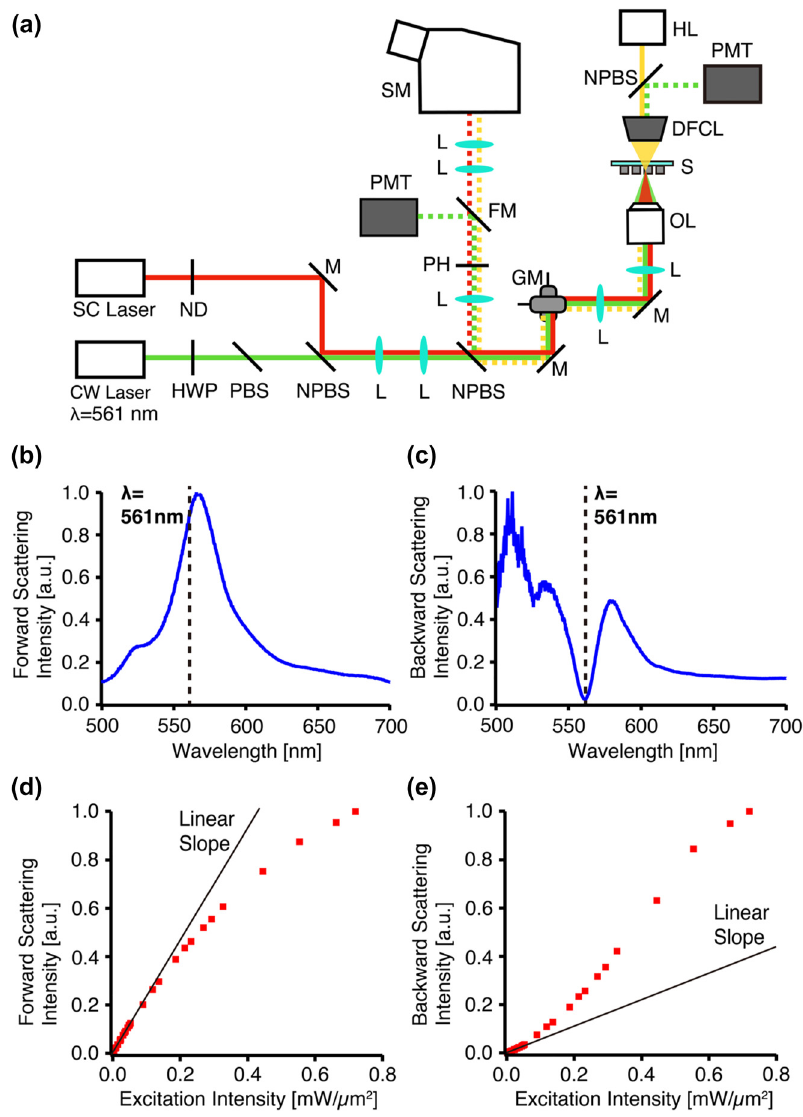
Figure 4: Experimental measurement of pho- tothermal nonlinear scattering from silicon metasurface. (a) Schematic of the optical